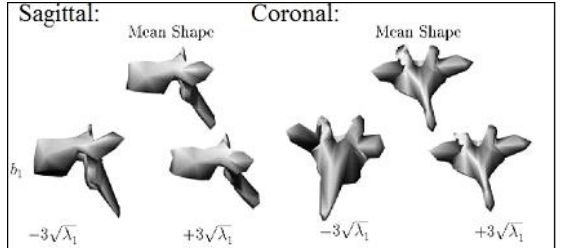
algorithm initialized by a rigid 3D/2D registration. The final mean error was 0.71 mm for lumbar and 1.48mm for thoracic vertebra.